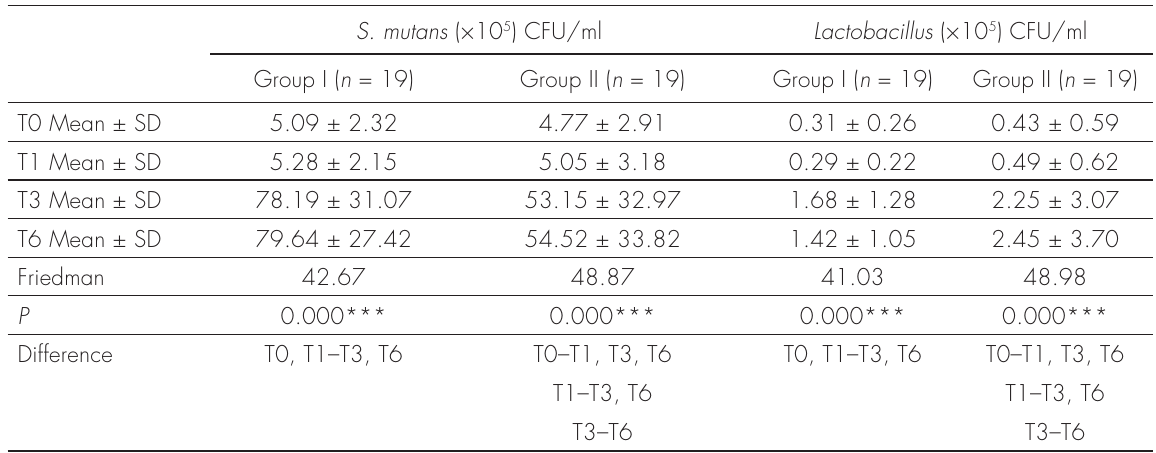
Table I. Comparison of the changes in S. mutans and Lactobacillus counts for fixed and removable appliances groups throughout the study. S. mutans (×10 5 )